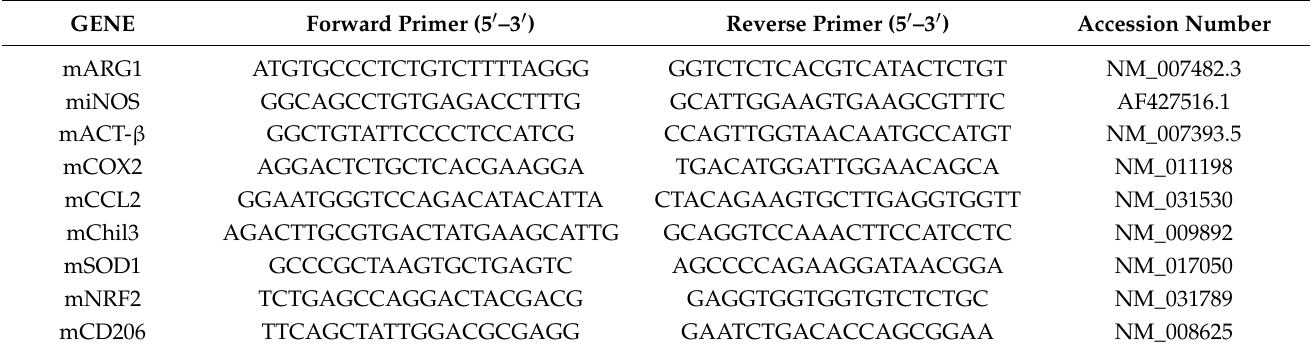
Table 1. Primers for Real-time